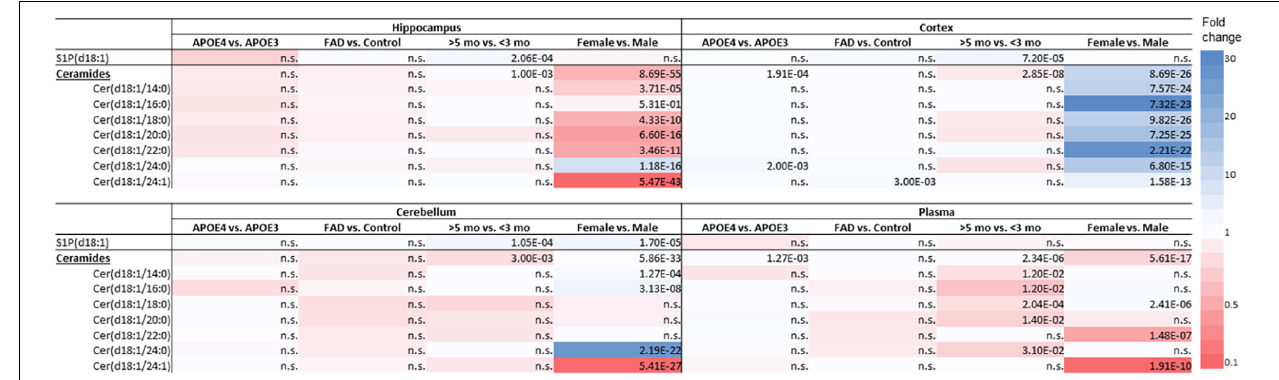
vs. ) on sphingolipid levels ♂ ♀